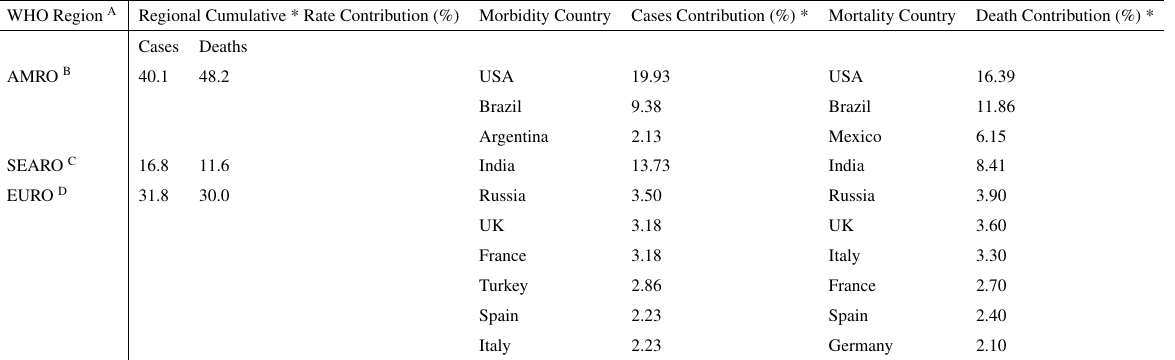
Table 1. Major countries in the global distribution of morbidities and mortalities cases by WHO